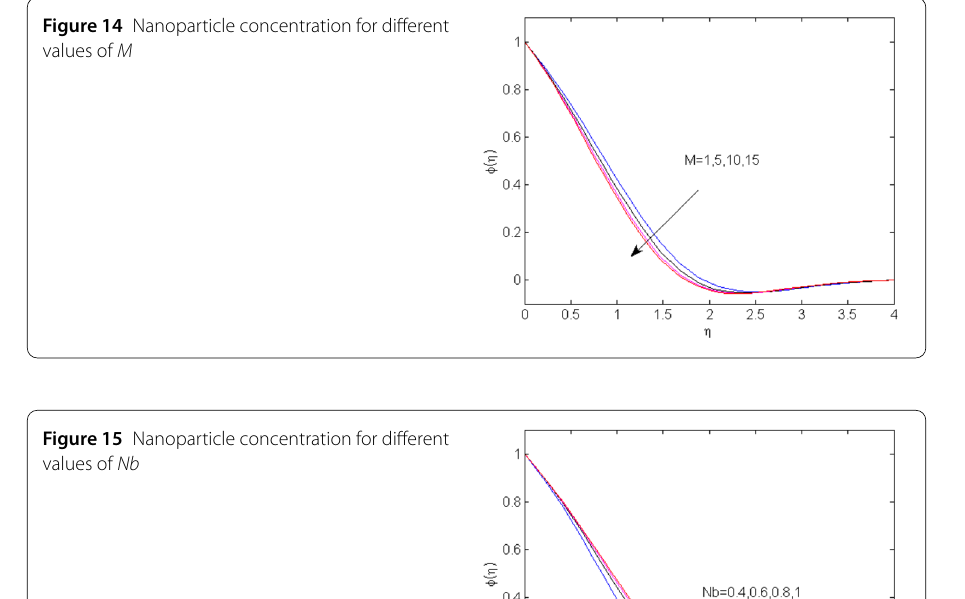
Figure 15 Nanoparticle concentration for different values of Nb